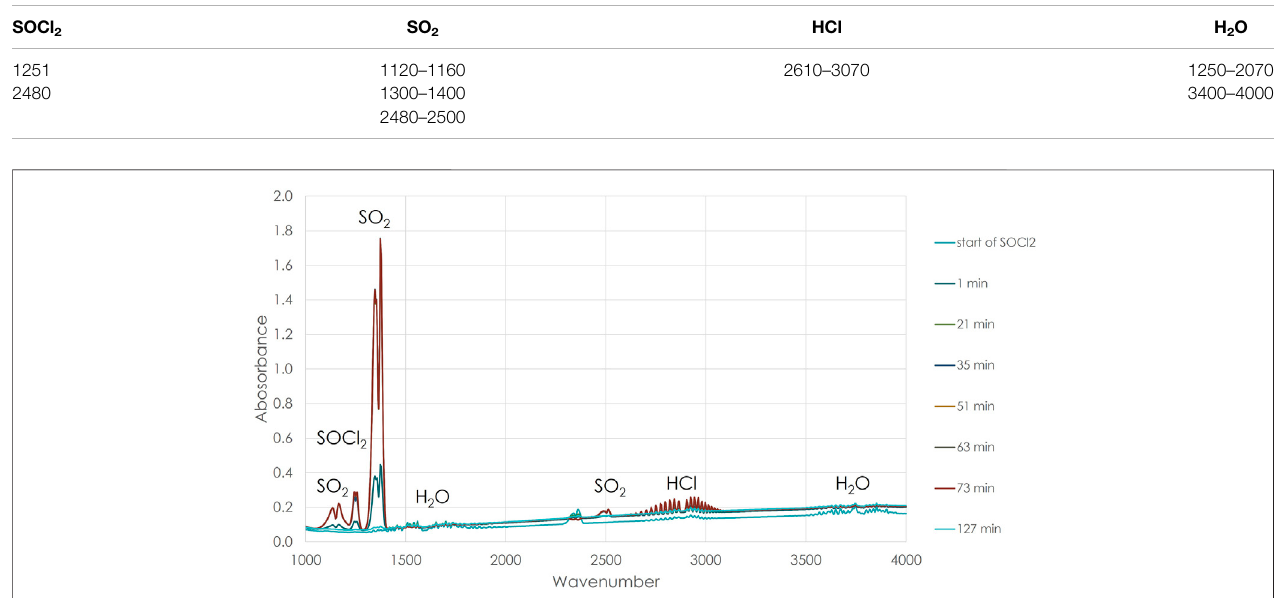
TABLE 2 | Infrared active bands used in this study (cm -1 ) (Coblentz Society Inc.